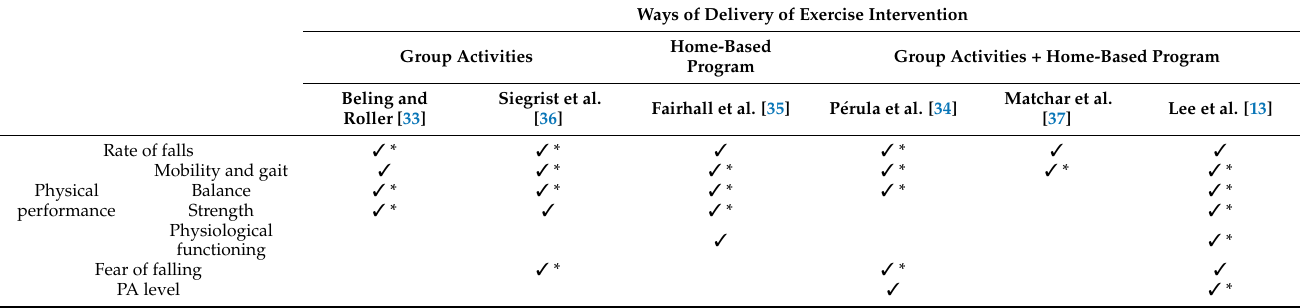
Table 3. Effects of different ways of delivery of the exercise interventions ( n =